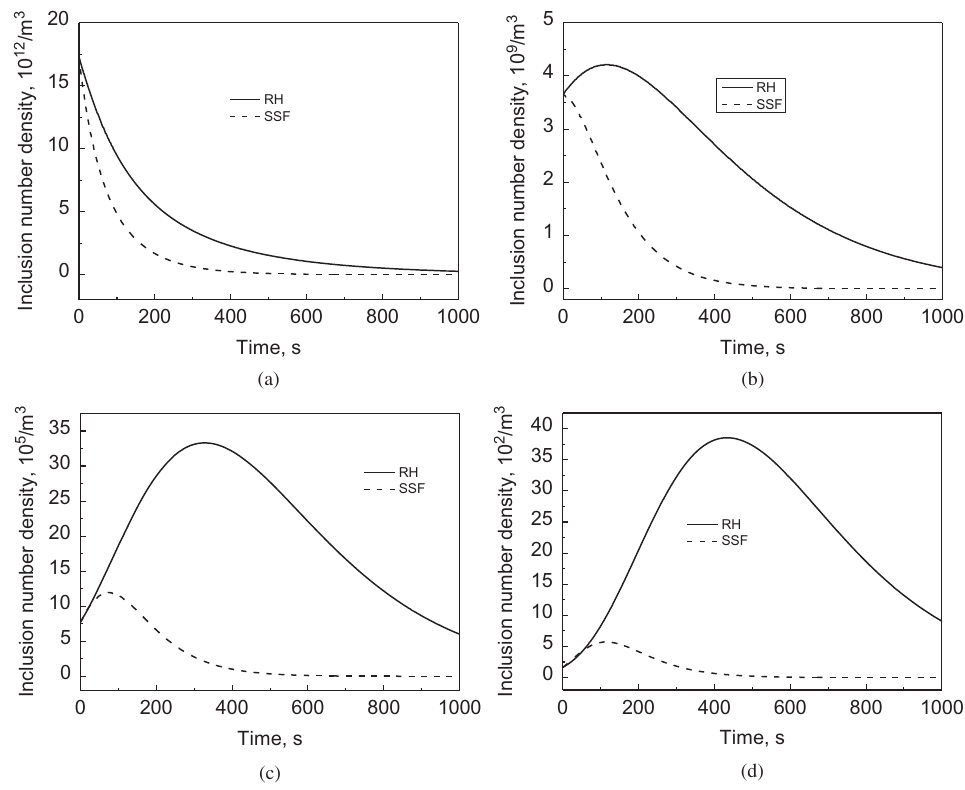
Figure 8: Variation of inclusion number density with time in RH and SSF. (a) 0~5 μ m (b) 5~10 μ m (c) 10~15 μ m (d) 15~ μ